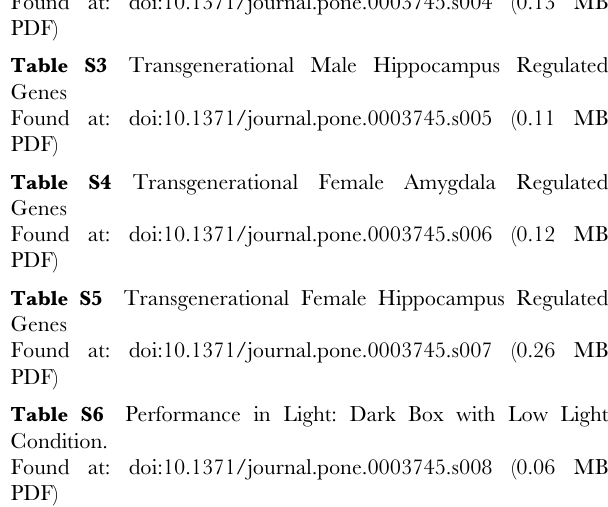
Table S2 Transgenerational Male Amygdala Regulated Genes